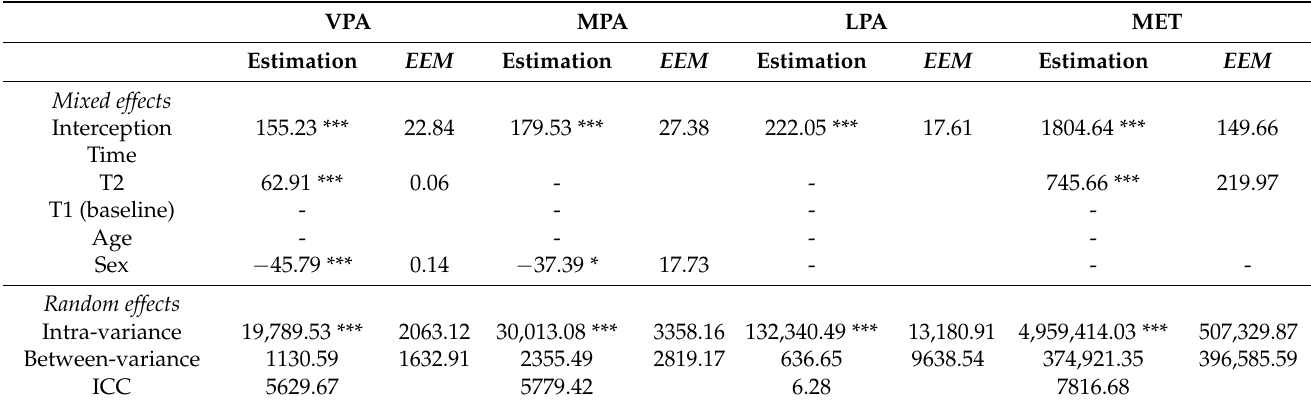
Table 2. Multilevel analysis of the physical activity levels of the students.